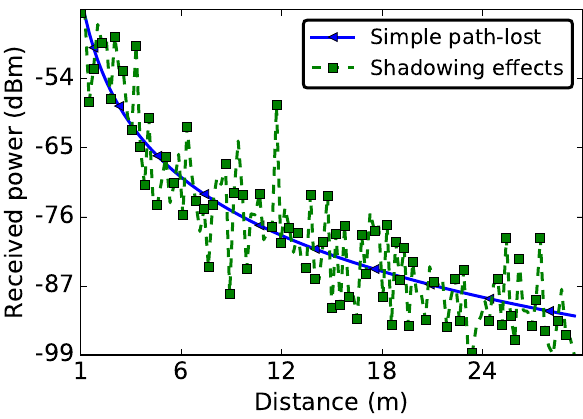
Figure 1. Theoretical received signal strength over a WSN link: α = 3.56, σ = 6.06, P t = 0 dBm, d 0 = 1